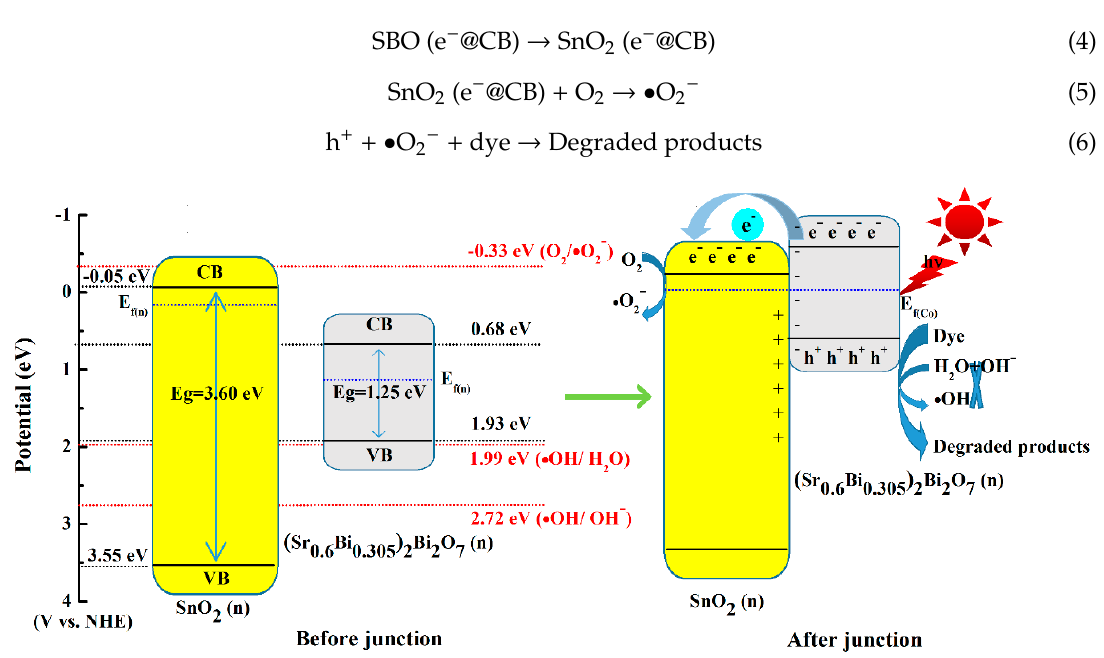
Figure 8. Possible mechanism of photocatalytic activity of SBO/SnO 2 heterojunction for the degradation of MB under visible light irradiation.